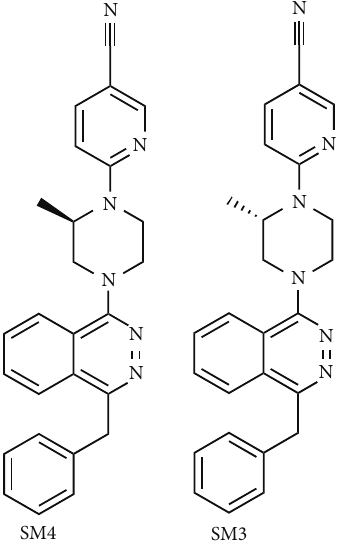
Figure 1: Structures of SM4 and